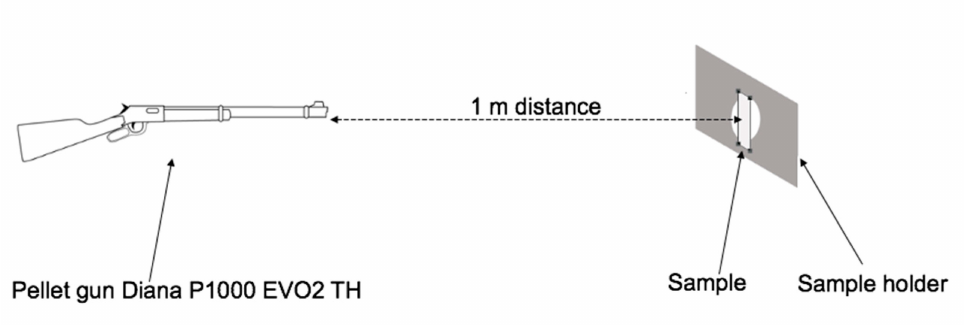
Figure 3. Schematic of the ballistic test with a pellet gun, a sample placed in a